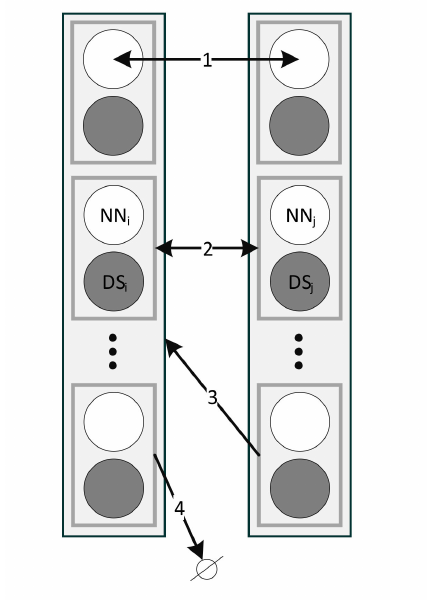
Figure 1. Expounder hybridization